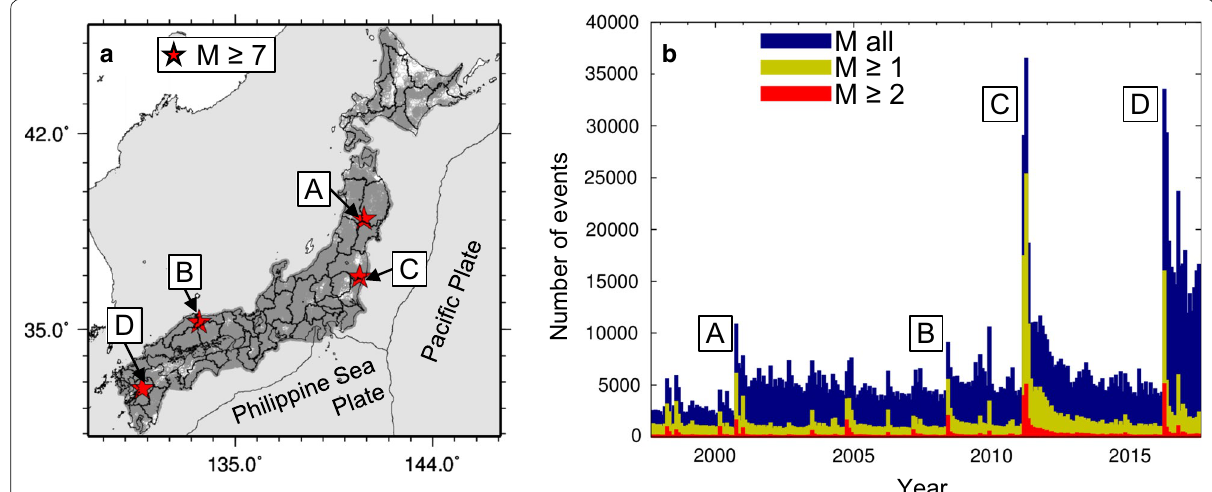
Fig. 1 JMA unified catalog for 20 years starting in October 1997. a Epicentral distribution (October 1, 1997, to July 25, 2017, M cate epicenters in the inland area (depth by month. The blue, yellow, and red bars indicate the entire magnitude, M